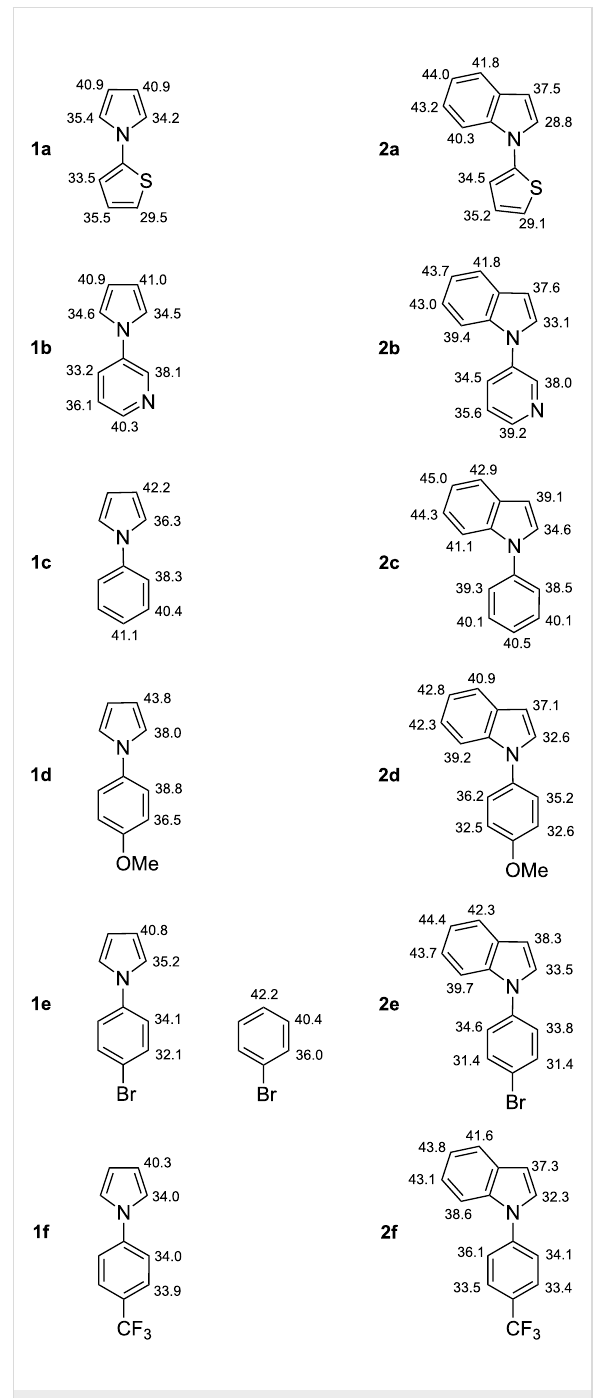
Figure 5: Calculated values of p K a (THF) of the compounds 1 and 2 , and bromobenzene.